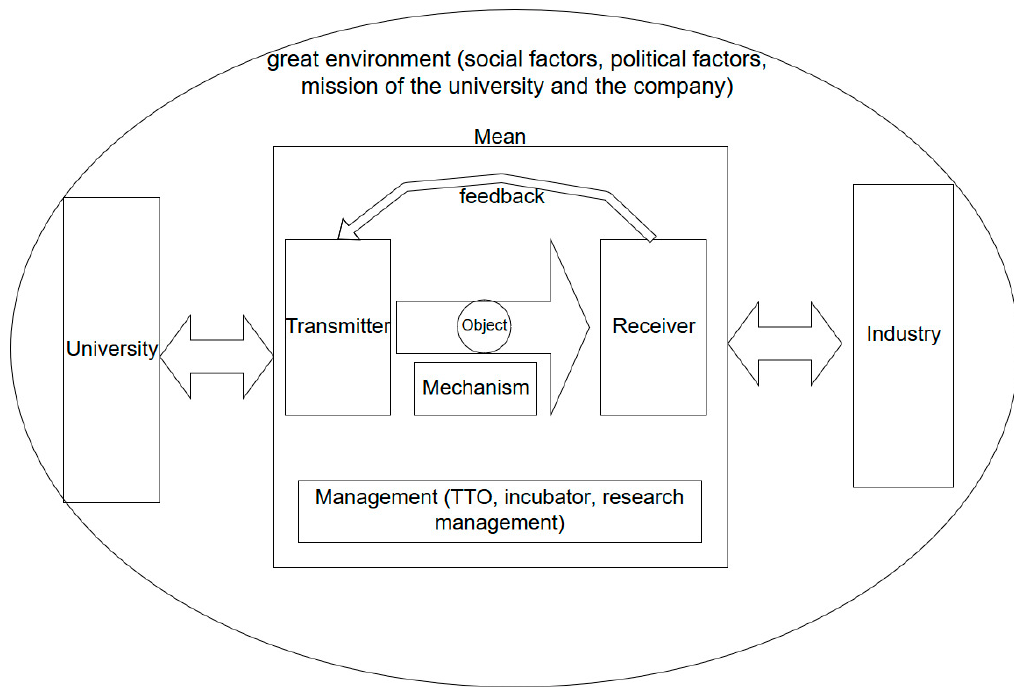
Figure 5. TT conceptual model of university-industry-collaboration (UIC).